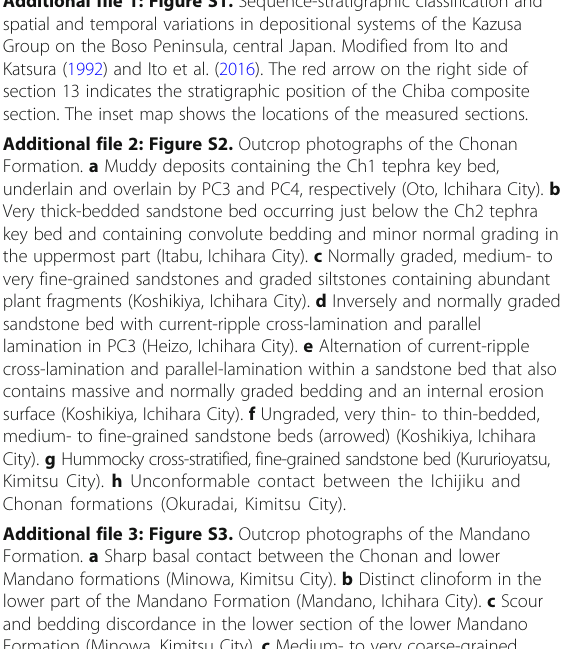
Additional file 5: Figure S5. Outcrop photographs of the Nagahama Formation. a Gently undulating waveforms and foreset bedding in conglomerates and overlying pebbly sandstones in the basal part of the Nagahama Formation (Tsukuriki, Kimitsu City). Solid and dotted red lines indicates an unconformable contact. b Trough cross-bedded conglomer- ates in the basal part of the Nagahama Formation (Sasage, Futtsu City).